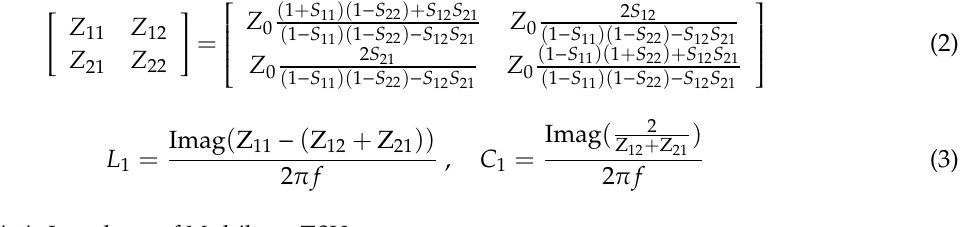
Figure 3. 1EA, 3EA, and 5EA multilayer Z 0 of Cu filled TSV.